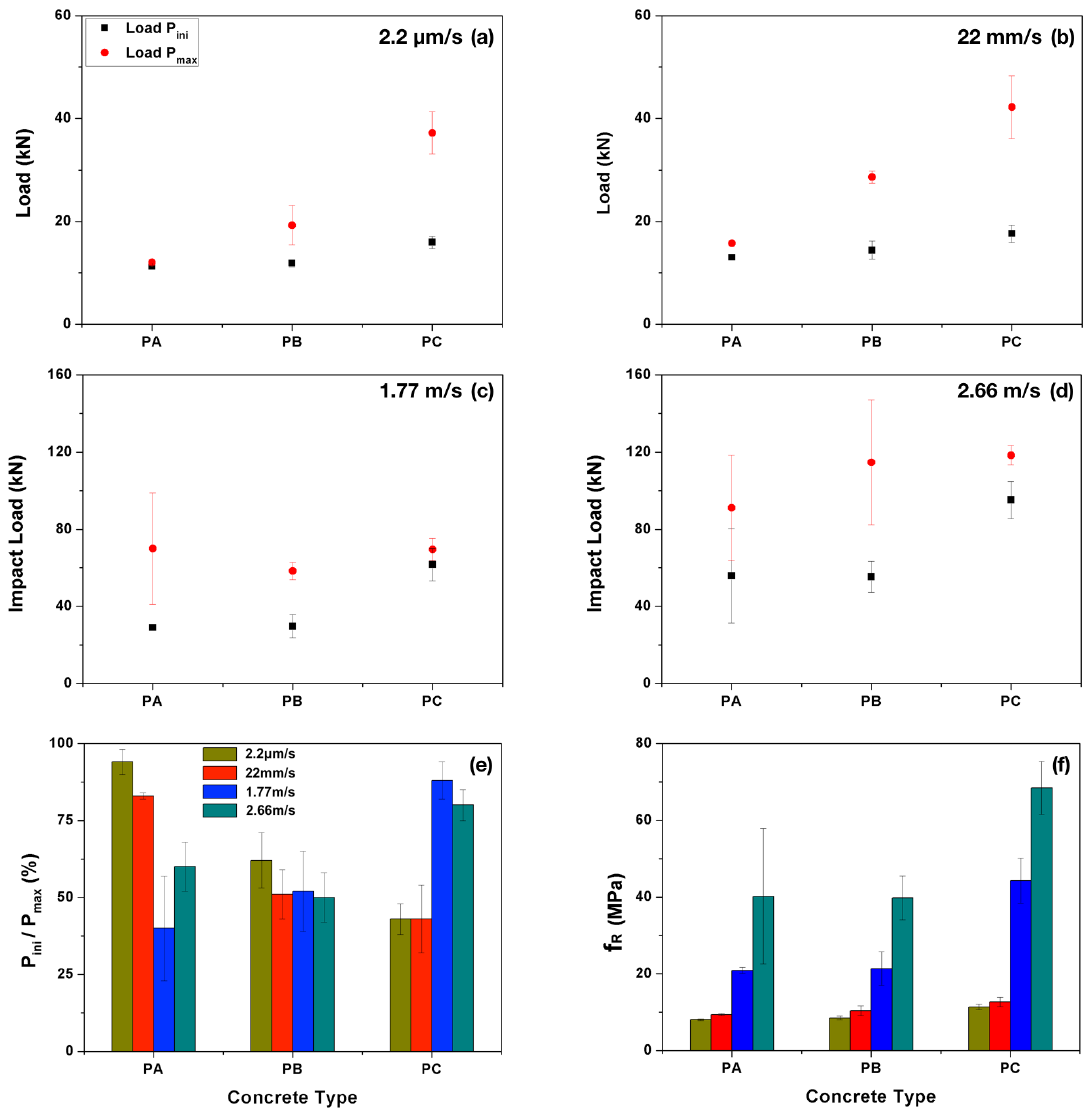
Figure 8. Peak load and initial load (with respective standard deviations) versus concrete type for the loading rate of ( a ) 2.2 µ m/s; ( b ) 22 mm/s; ( c ) 1.77 m/s and ( d ) 2.66 m/s, respectively; ( e ) the ratio between both loads; and ( f ) the first-crack strength, f R